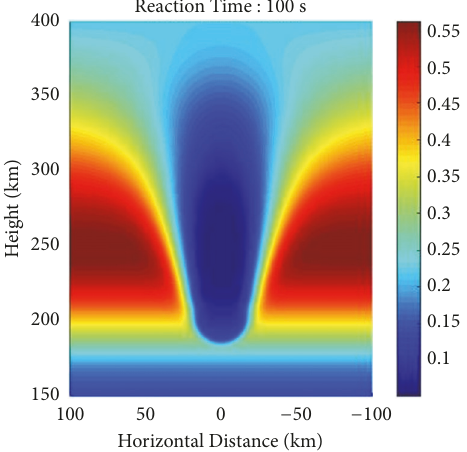
Figure 2: Electron density profile of H 2 O released from the ionosphere in the ballistic missile exhaust plume in Nanjing in